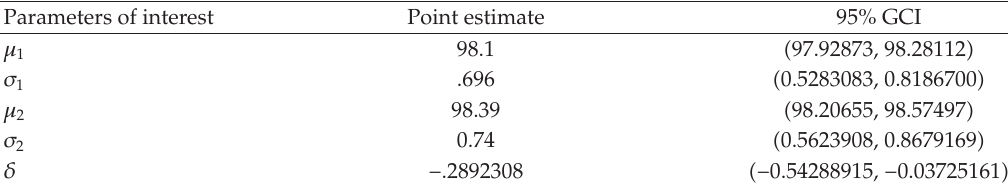
Table 3: Numerical results for the normal body temperature